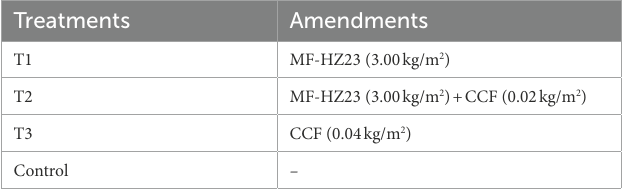
MF-HZ23, microbial fertilizer based A. brunneoviolaceus HZ23, pH 7.2, organic matter contents (OMC) ≥ 68.75%, NPK content 7.8%; CCF, chemical compound fertilizer, pH 4.5, NPK content